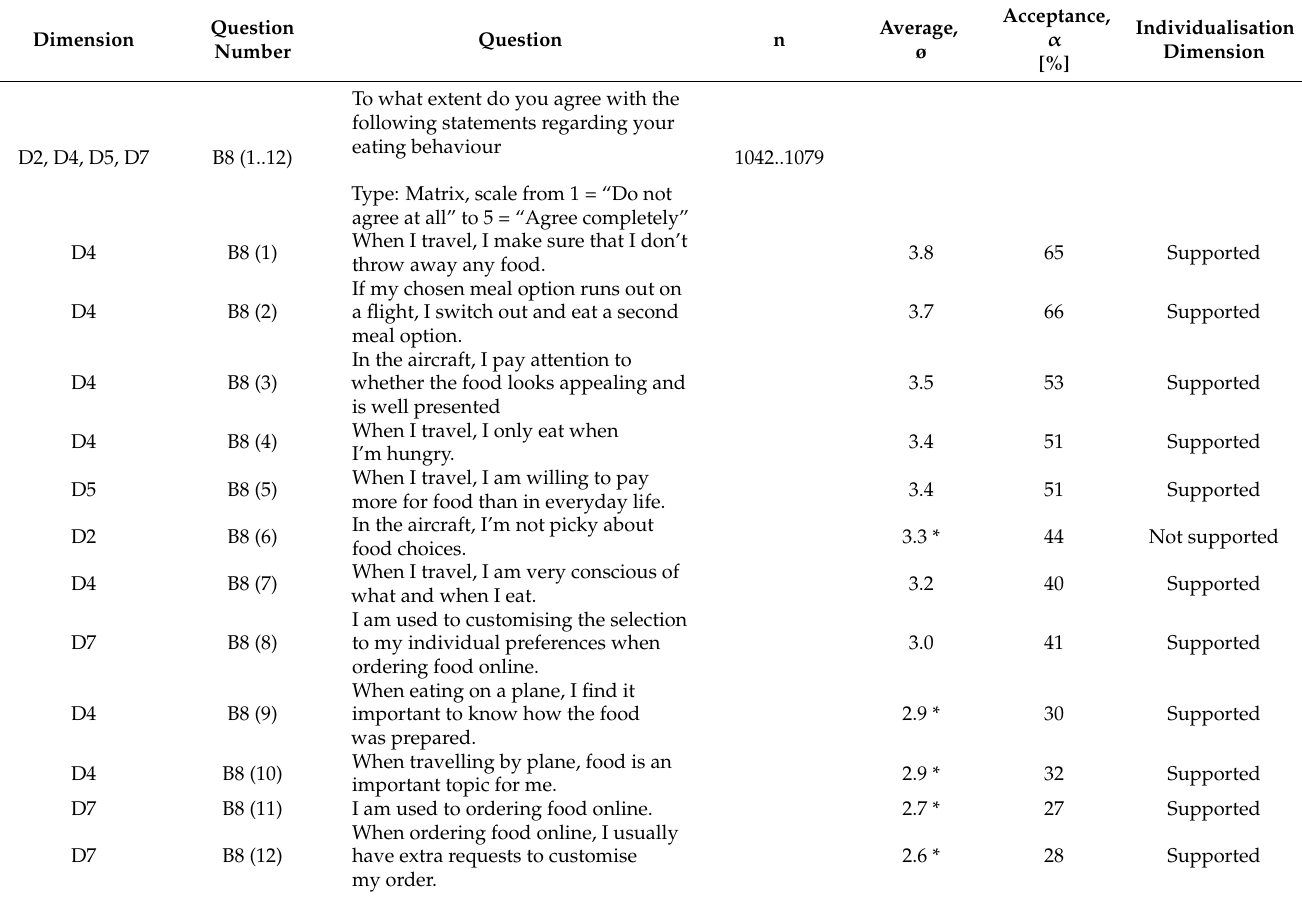
Table A4. Survey individualisation of ICS—questions and